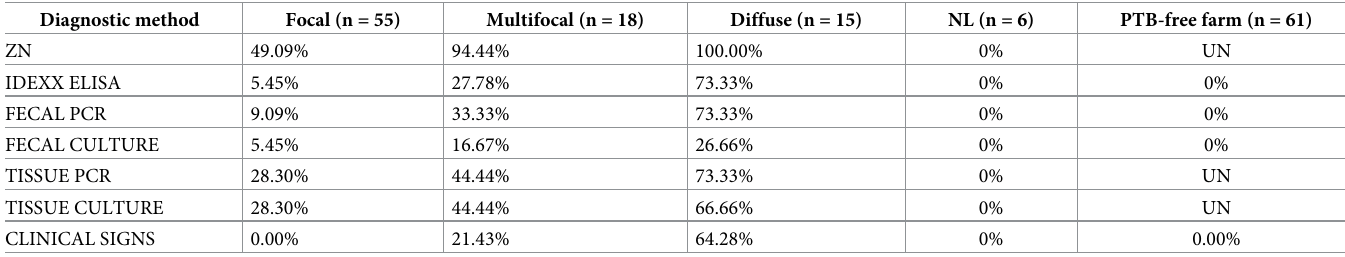
Table 2. Assessment of MAP infection status in 155 Holstein Friesian cows included in the study. Diagnostic